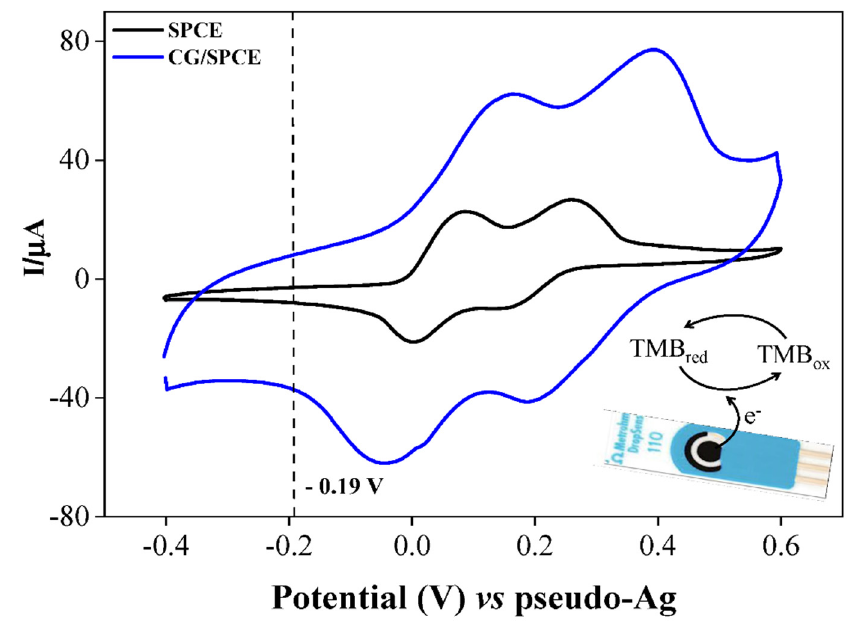
Figure 4. Cyclic voltammograms for SPCE (black) and CG/SPCE (blue) in TMB solution. The results showed an increase in peak current in GC/SPCE (Ipa I = 62.2 μ A, Ipa II = Ipc I = − 62.3 µ A, and Ipc II = − 41.4 µ A) as compared with bare SPCE (IpaI = 22.4 µ A, 76.8 μ A, Ipc I = − 62.3 μ A, and Ipc II = − 41.4 μ A) as compared with bare SPCE (IpaI = 22.4 IpaII = 26.2 µ A, Ipc I = − 21.5 µ A, and Ipc II = − 9.4 µ A) due to the high conductivity μ A, IpaII = 26.2 μ A, Ipc I = − 21.5 μ A, and Ipc II = − 9.4 μ A) due to the high conductivity of